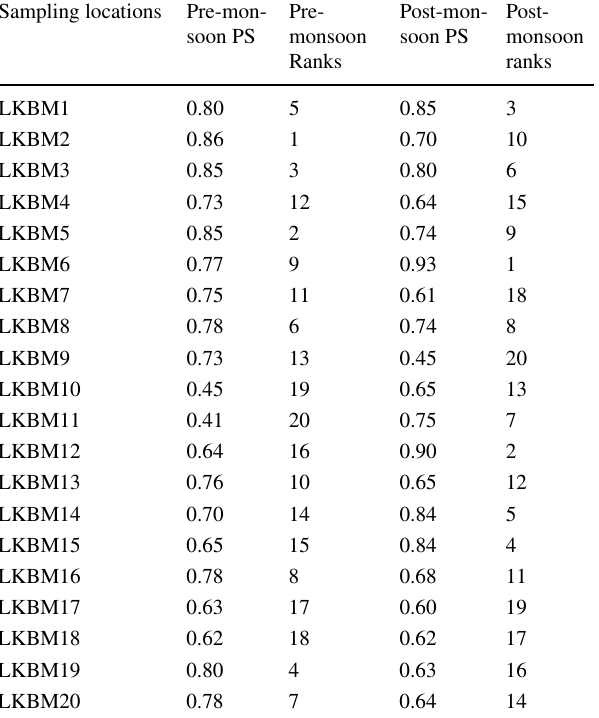
Table 7 EWQI in sampling locations at North Guwahati Sampling locations